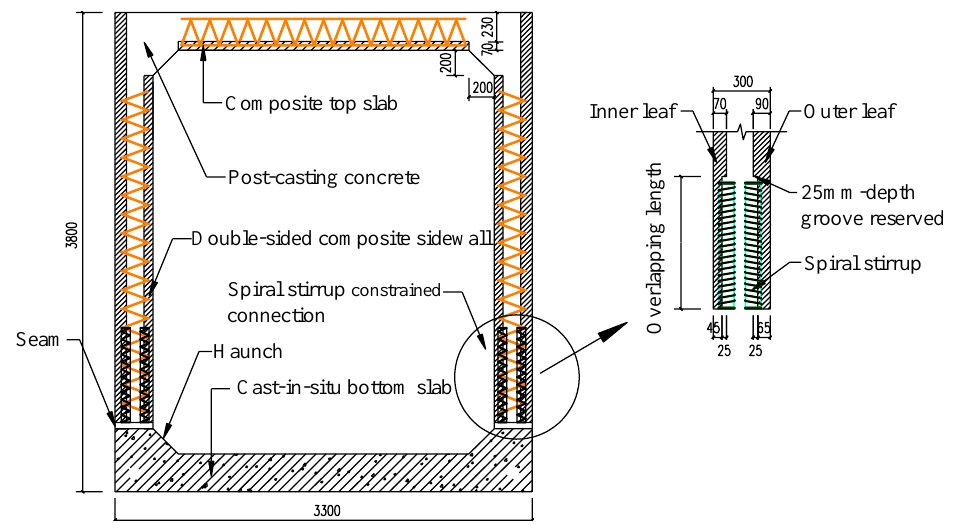
Figure 1. Schematic diagram of composite precast utility tunnel with spiral stirrup-constrained con- nection.